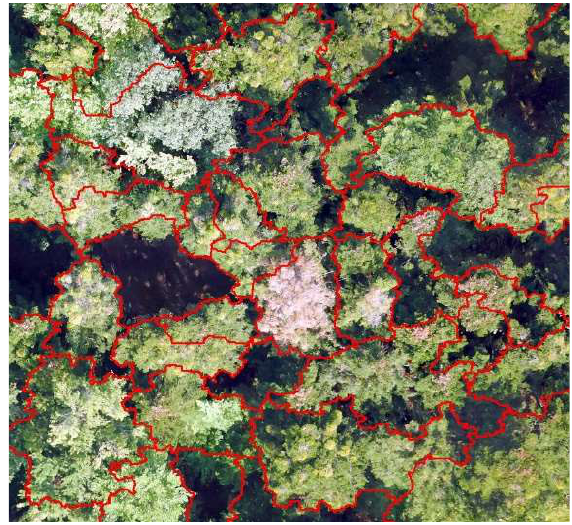
Figure 5. Polygon of tree crowns